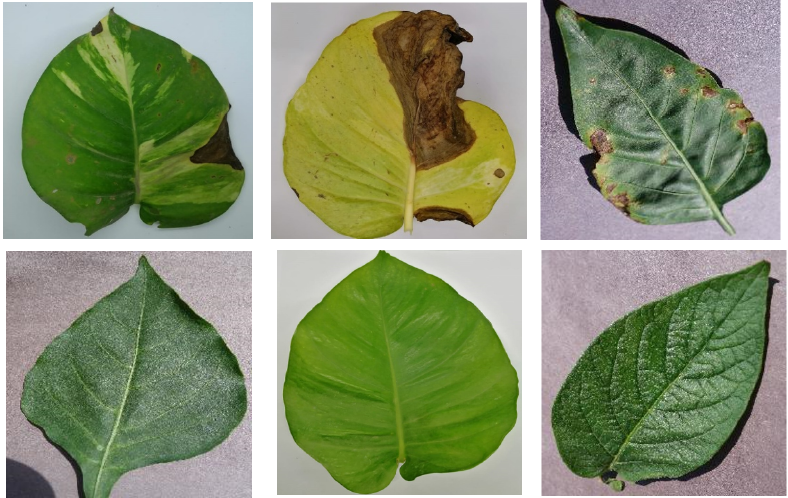
Figure 2. Data set visual